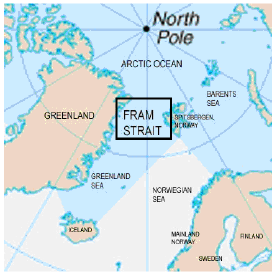
Fig. 1 The study region in the Fram